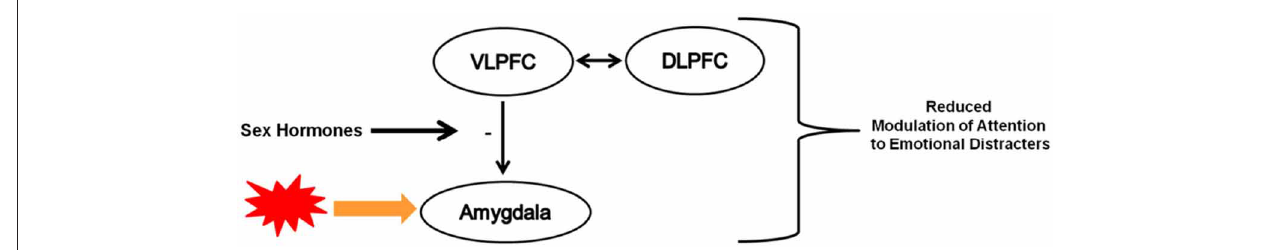
FIGURE 2 | Simplified illustration of heuristic model describing the potential influence of the increase in sex hormones during pubertal maturation on the functioning of fronto-limbic circuitry implicated in the modulation of attention to emotionally salient distracters. For simplicity,